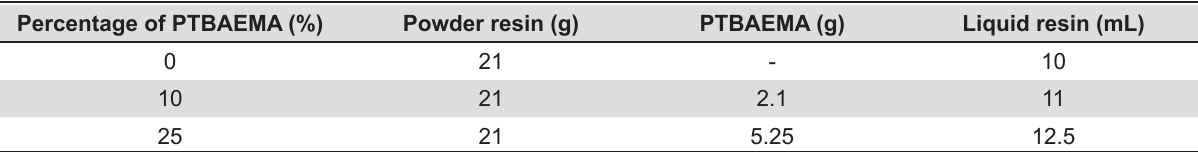
Table 1- Groups according to the percentage of poly(2-tert-butylaminoethyl) methacrylate